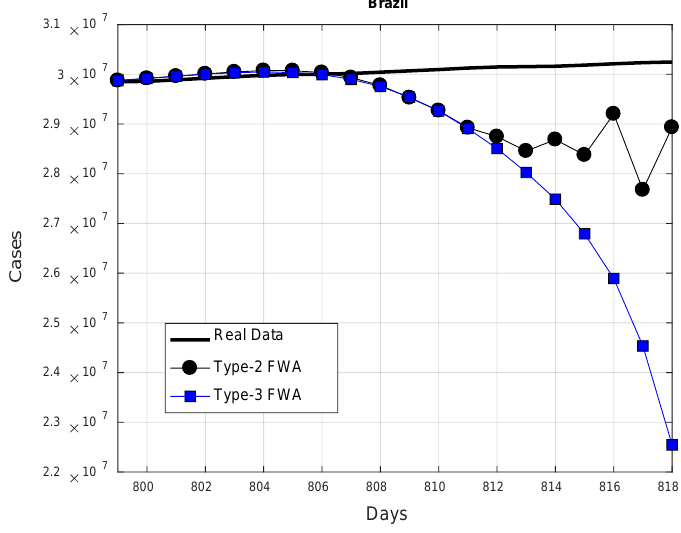
Figure 15. Future prediction (Brazil).